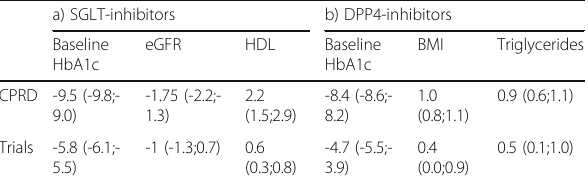
Table 1 (abstract O6). Change in HbA1c in mmol/mol at 6 months (with 95% confidence intervals) per standard deviation greater baseline value of predictor. A negative value represents a reduction (improvement) in